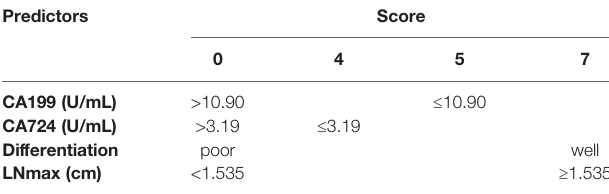
TABLE 4 | Risk Score of Prediction Model for TRG.